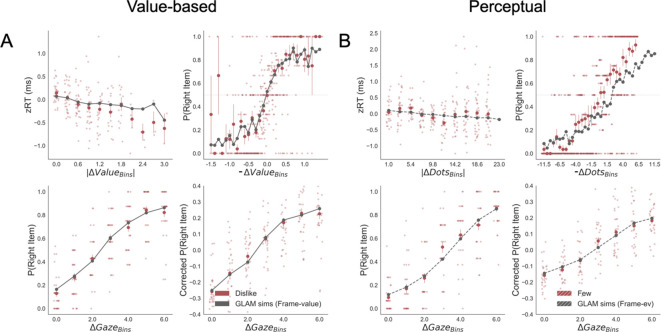
Replication of behavioural effect of interest by simulations using the GLAM fitted for dislike (A) and fewest frames (B).Frame-relevant evidence was used to fit the model. The four panels present four relevant behavioural relationships found in the data. Top left: faster responses (shorter RT) when the choice is easier (i.e. easier choices are found with higher |ΔValue| in value-based and higher |ΔDots| in perceptual). Top right: probability of choosing the right alternative increases when the difference in evidence (value or number of dots) is lower in the alternative at the right side of the screen (notice that -ΔValue and -ΔDots are calculated considering left minus right options). Bottom left: the probability of choosing the right alternative depends on the gaze difference favouring the right option. Bottom right: the gaze influence on choice depending on the difference in gaze time between both alternatives. Solid red dots depict the mean of the data across participants in dislike and fewest frames. Light red dots present the mean value for each participant. In the Value Experiment, the solid grey lines show the average for model simulations. In the Perceptual Experiment, segmented grey lines show the model simulations. Data are binned for visualisation.